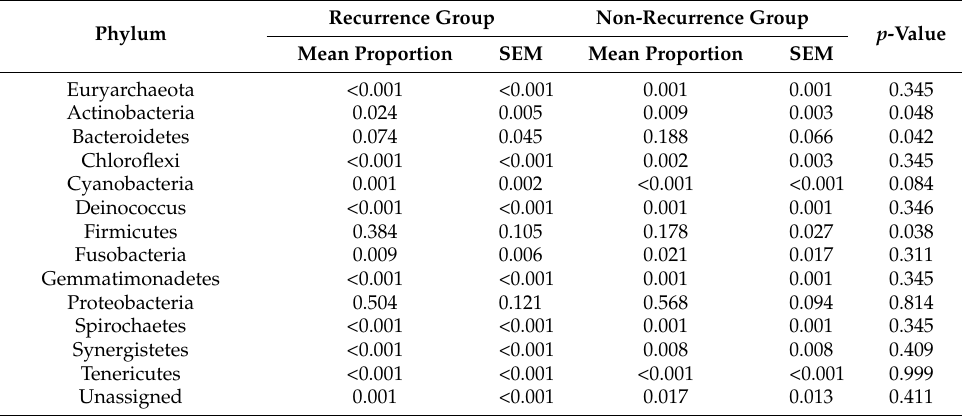
Table 2. List and relative proportion of phylum identified by next-generation